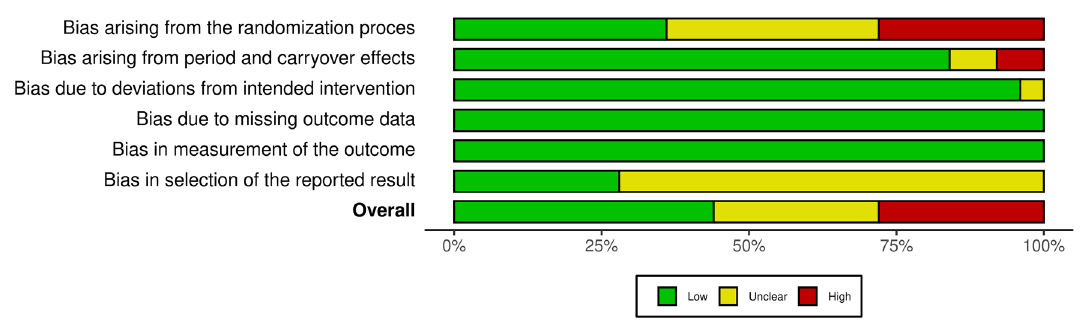
Figure 2. Risk of bias assessment for cross-over trials (based on the second version of Cochrane risk of bias